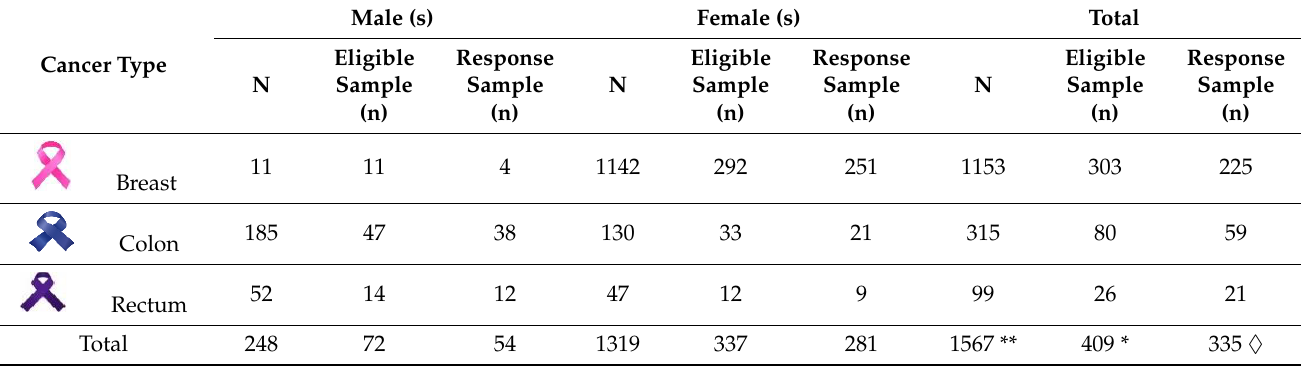
Table 1. Proportionate sample size distribution per gender (male, female) and cancer primary distribution assuming a finite total population of 1567.